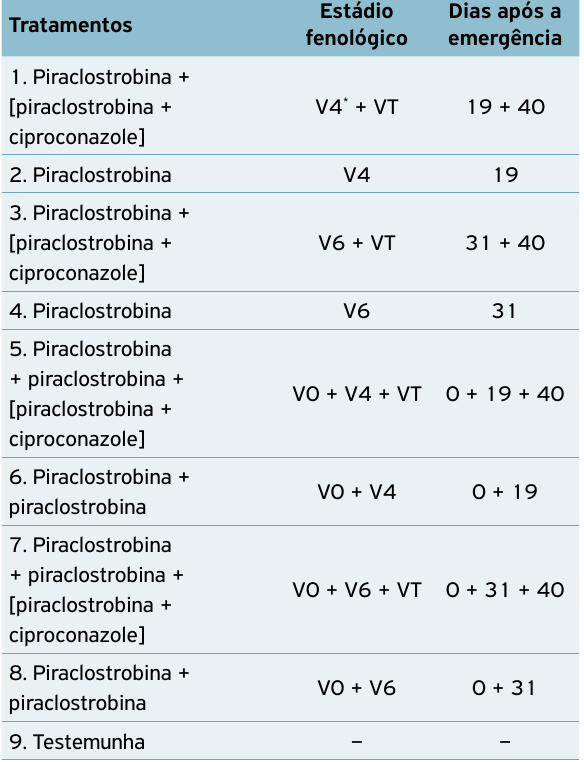
Tabela 1. Descrição das combinações das aplicações de piraclostrobina de acordo com o estádio fenológico. Jataí, GO,